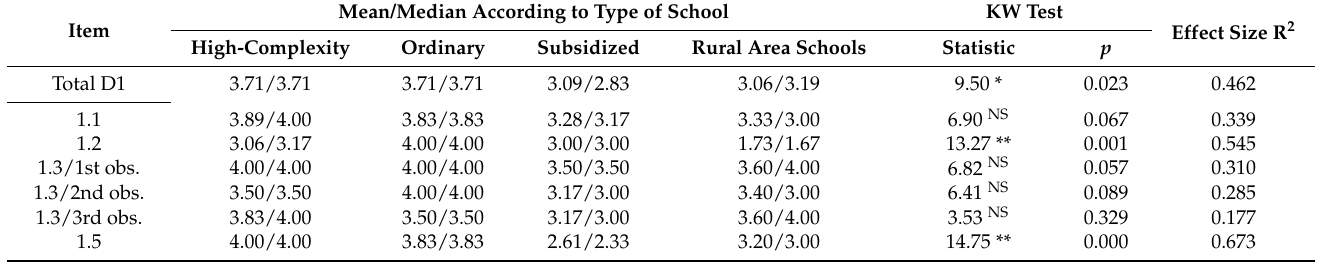
D1: Safety and structure as a function of school type. ( n =